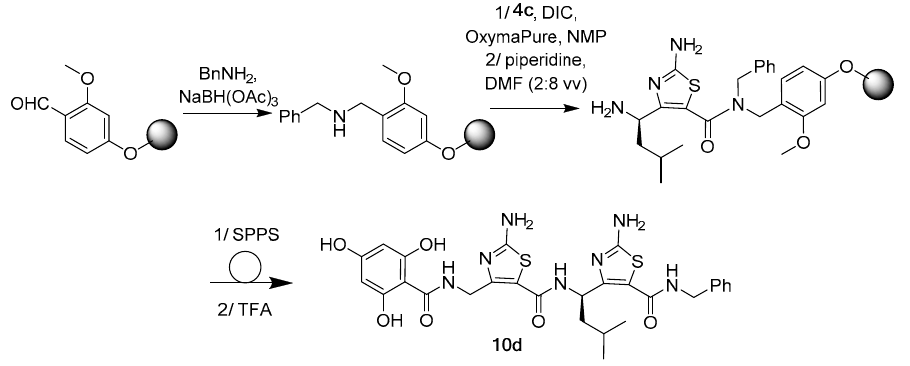
Scheme 3. Solid phase peptide synthesis (SPPS) approach to access ATC-based γ -dipeptide 10d